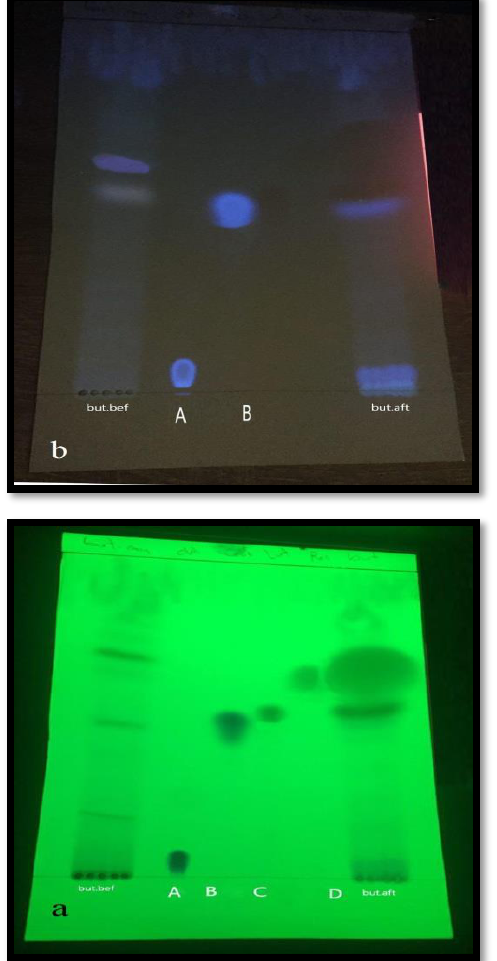
Figure 1-TLC Chromatogram at 254nm(a), at 365nm(b) for n-butanol fraction before hydrolysis(left),and after hydrolysis(right); A:chlorogenic acid B: caffeic acid C: luteolin D :resorcinol, mobile phase: CHCl 3 :M 2 OH : Formic acid (87.5 : 10: 2.5) For the preperative TLC, bright lines were